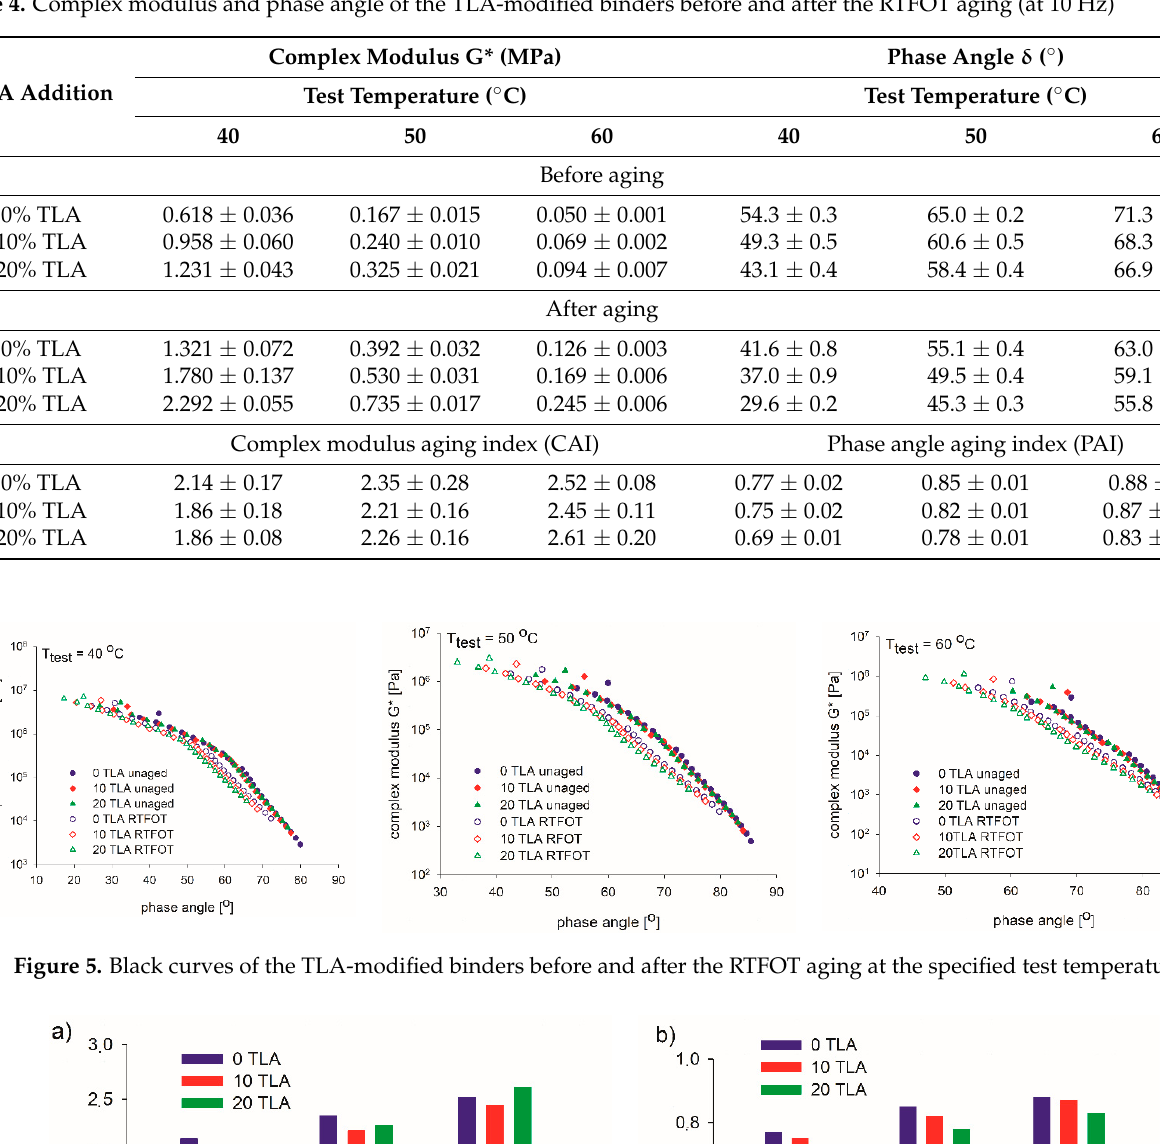
Table 5. Zero shear viscosity of TLA-modified binders before and after aging.